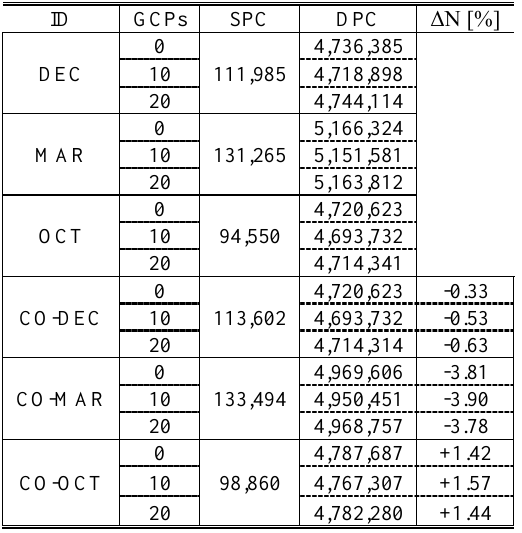
Table 2. Summary of points included in the Sparse Point Clouds (SPC) and Dense Point clouds (DPC) for the three different setups (0, 10 and 20 GCPs) per each analysed sub- chunk. Percentage rate (ΔN) between the amount of points contained in the co-aligned clouds and the original ones. The labels DEC, MAR, OCT indicate respectively the datasets of December, March, October; the labels preceded by the prefix CO the ones obtained by Co-Split.